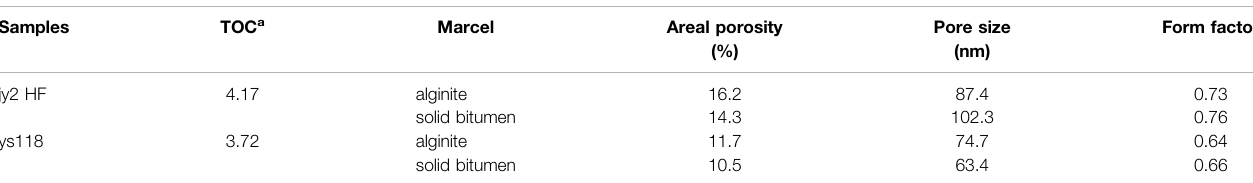
TABLE 1 | OM pores Parameters in the Longmaxi Shale from the FE-SEM images. Samples TOC